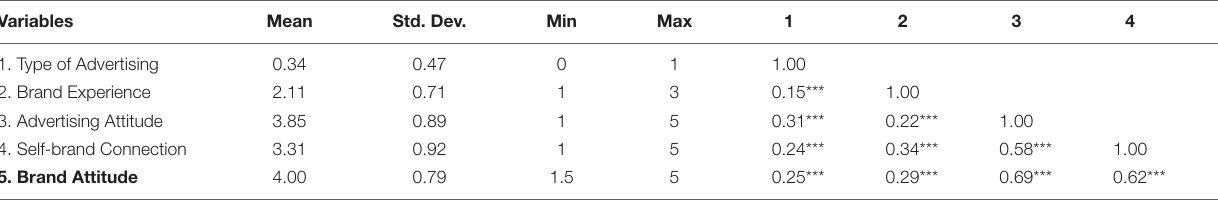
TABLE 2 | Descriptive statistics and correlations. Variables Mean Std. Dev.